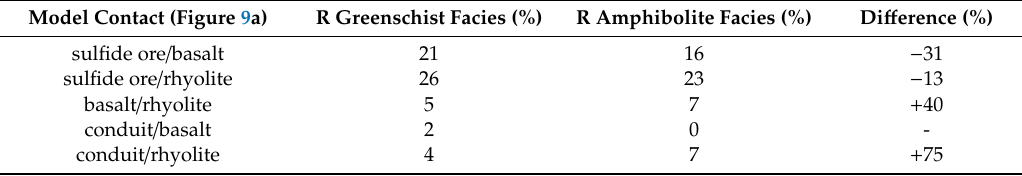
Table 9. Seismic reflection coe ffi cients R ( R = ( Ω 2 − Ω 1 ) / ( Ω 1 + Ω 2 ) × 100%, where Ω 1 and Ω 2 are the acoustic impedances of the rock materials in contact with each other) between the ore, conduit, and host rocks and their di ff erences for the acoustic finite di ff erence models for the greenschist and amphibolite facies